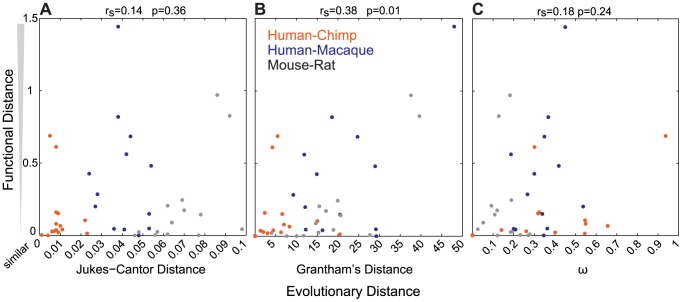
Sequence similarity does not accurately predict the functional properties of ORs.For each OR pair, the (A) Jukes-Cantor (nucleotide) distance (B) Grantham (amino acid) distance and (C) ω (dN/dS) is plotted against the functional distance, as defined by the correlation (1-R, Table S2) of the response across the 42-odor panel for ORs responding to more than three odors. ω values for human-chimp OR2W1 were included in the calculation but eliminated from the plot for better visual representation. Values closer to zero are more similar in sequence and function. Jukes-Cantor and ω do not correlate with functional distance (J-C rs = 0.14, p = 0.36; ω, rs = 0.18, p = 0.24) while Grantham's distance has a correlation to functional distance (rs = 0.38, p = 0.01).